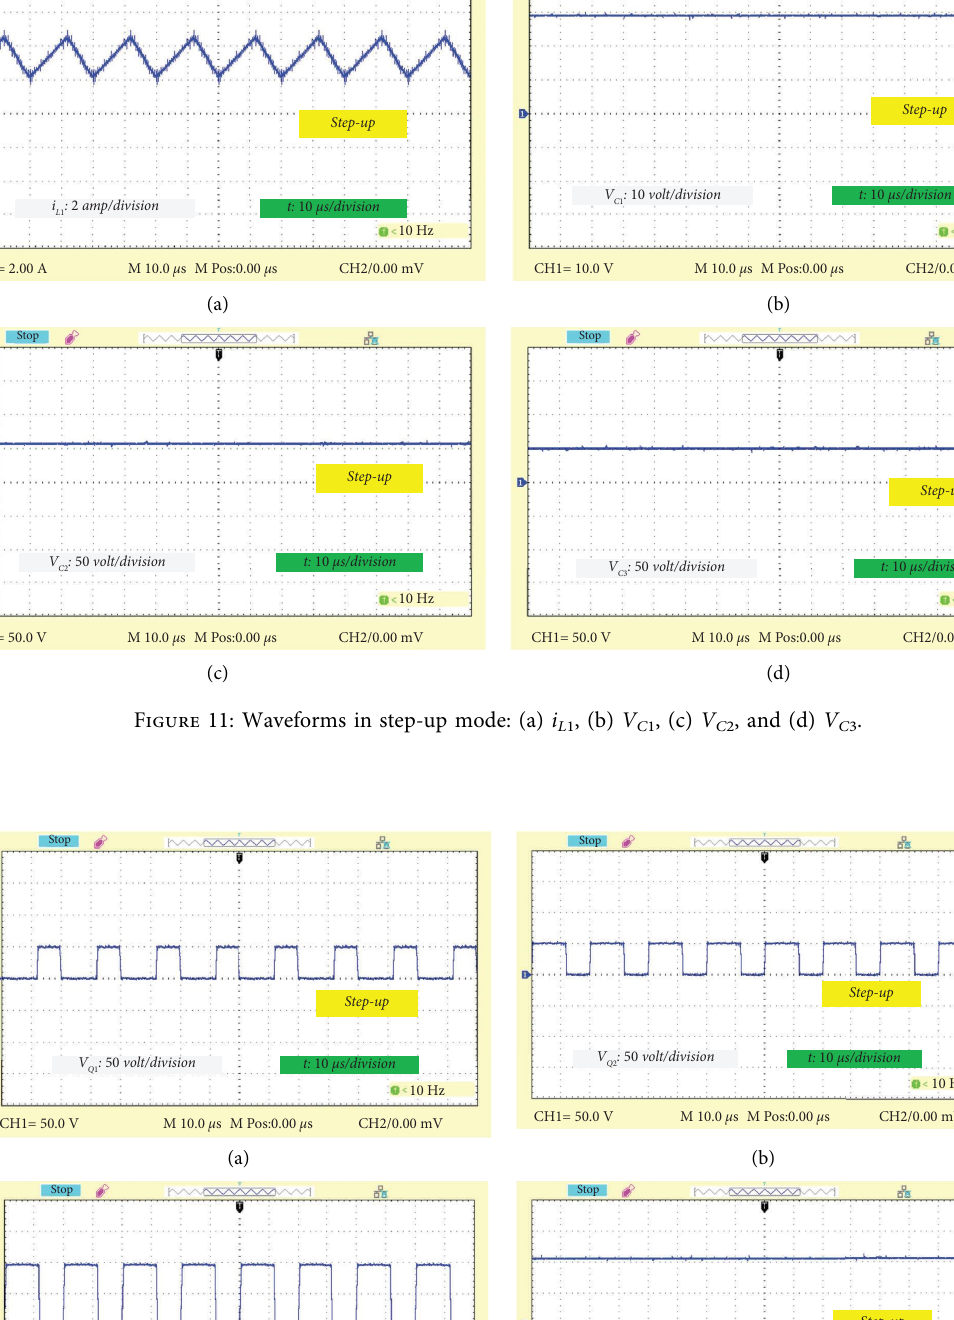
Q 1 , (b) V Q 2 , (c) V Q 3 , and (d) V o